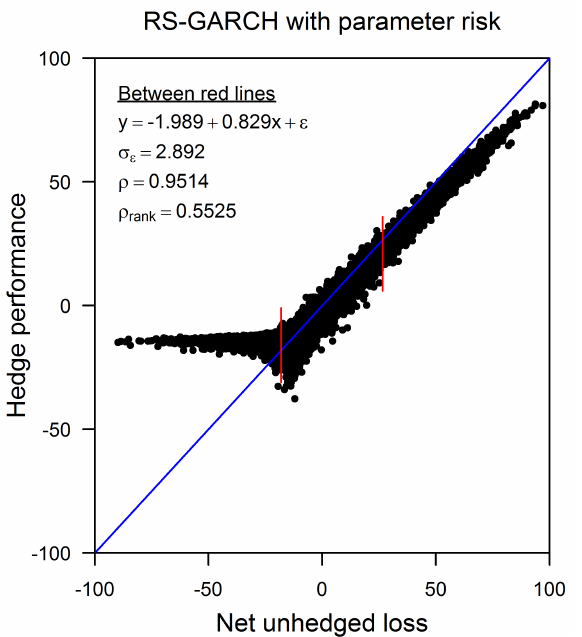
Figure 2. Relationship between the hedge performance and the net unhedged loss based on 100,000 daily scenarios projected the RS-GARCH model with parameter risk. Only the underly- ing put option is delta